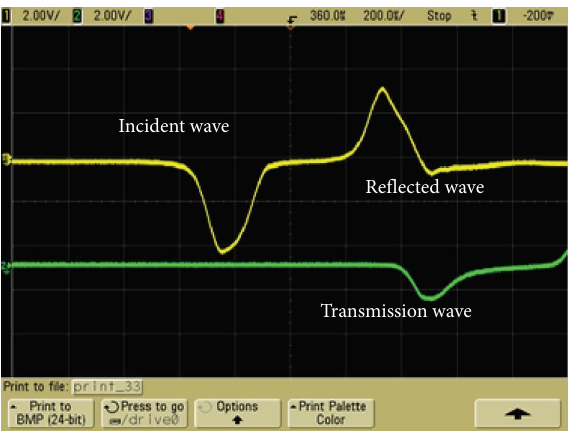
Figure 6: Uniaxial impact compression test signal of fy ash